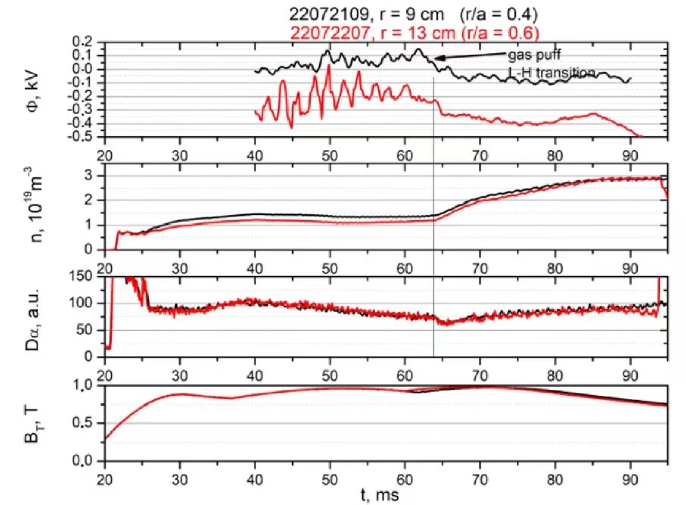
Figure 5. From top to bottom: Plasma potential evolution measured with HIBP in two similar shots but at different locations, electron number density evolution, D α emission., and toroidal magnetic field. L-H transition occurs at t = 64 ms after the co-NBI (21.keV @ 16 A) pulse